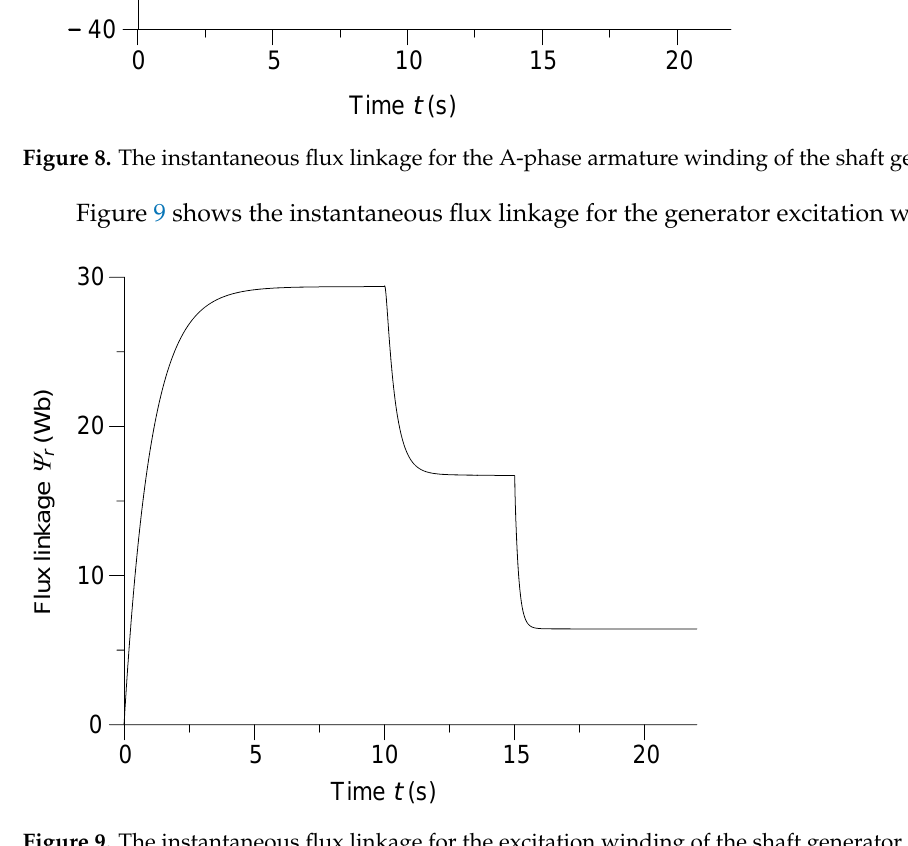
Figure 9. The instantaneous flux linkage for the excitation winding of the shaft generator.